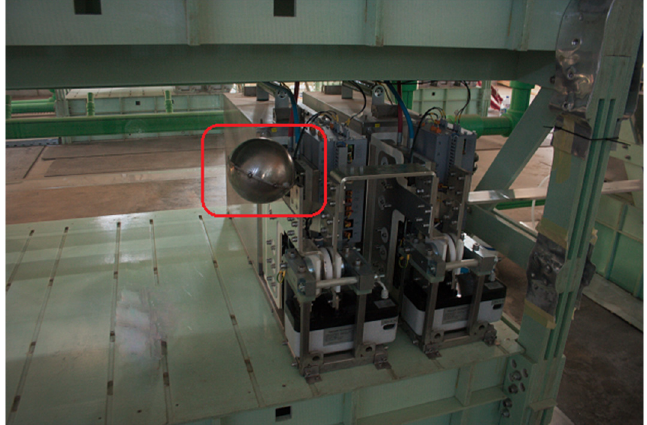
Figure 11. Metal sphere attached to the far end of the sub-modules.